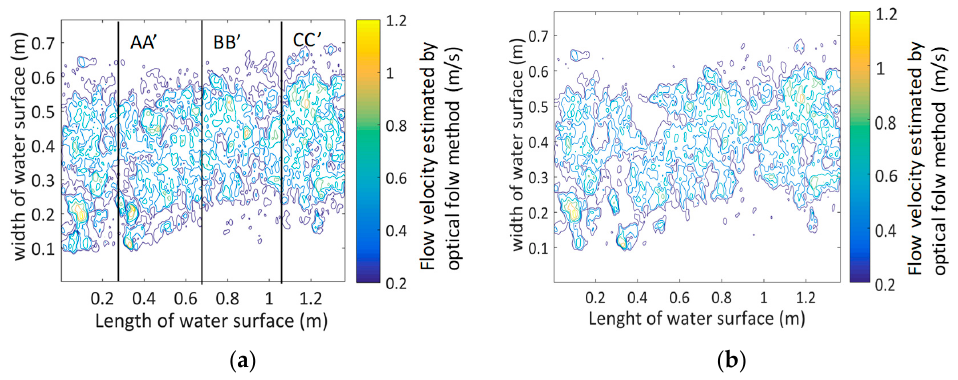
Figure 4. Contour map of the surface velocity of water flow (SVWF) of different frames estimated by Farneback optical flow method: ( a ) contour map of the 38th frame; ( b ) contour map of the 40th frame. Water 2019 , 11 , x FOR PEER REVIEW